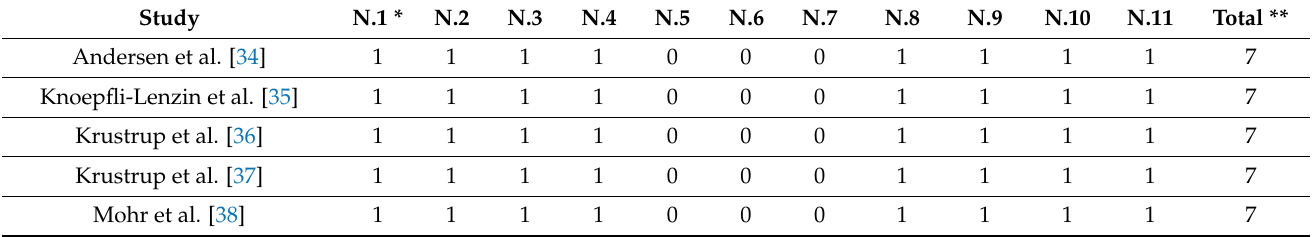
Table 4. Physiotherapy Evidence Database (PEDro) scale ratings.